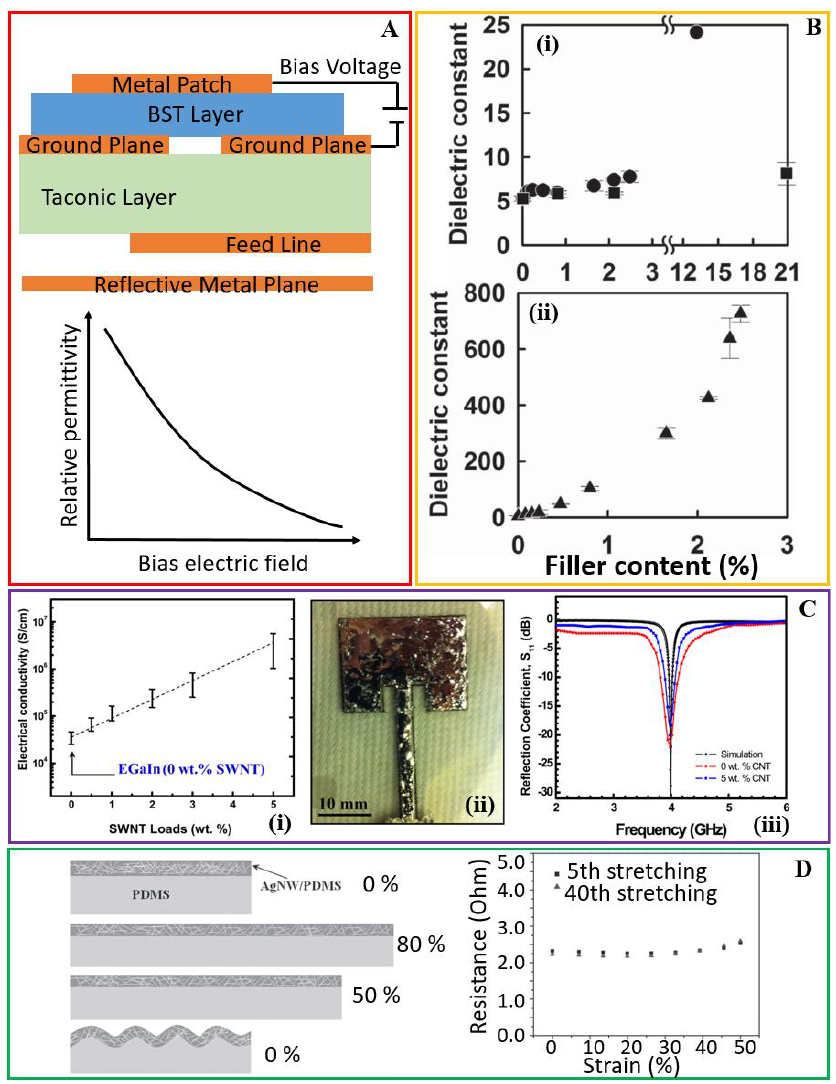
Figure 6. Future directions for the stretchable antenna. ( A ) ( i ) Applying a bias voltage between the patch and ground plane changes the effective dielectric constant of the (Ba, Sr)TiO 3 (BST) substrate, yielding a frequency-configurable patch antenna. ( B ) The dielectric constant of the nanopaper composite at 1.1 GHz as a function of different filler content (volume ratio) of ( Bi ) BaTiO 3 (square), Ag particles (circles), and ( Bii ) Ag nanowires. Reproduced with permission from [11]; Copyright 2015, John Wiley and Sons. ( Ci ) The conductivity of the EGaIn/SWNTs composite as a function of the nanotube loads (weight ratio from 0% to 5%). SWNTs: single-wall carbon nanotubes. ( Cii ) Photograph of a patch antenna with the conductive composite as radiation parts on a PDMS substrate. ( Ciii ) Measured and simulated reflection coefficients for antennas with different nanotube loads. Reproduced with permission from [119]; Copyright 2013, American Institute of Physics. ( Di ) Schematic showing the deformation of the top AgNW/PDMS composite layer during the stretching and releasing process, highlighting the buckling of the AgNW/PDMS layer due to the irreversible fiber arrangement. ( Dii ) Resistances as a function of tensile strains (0–50%) for the AgNW/PDMS composite in